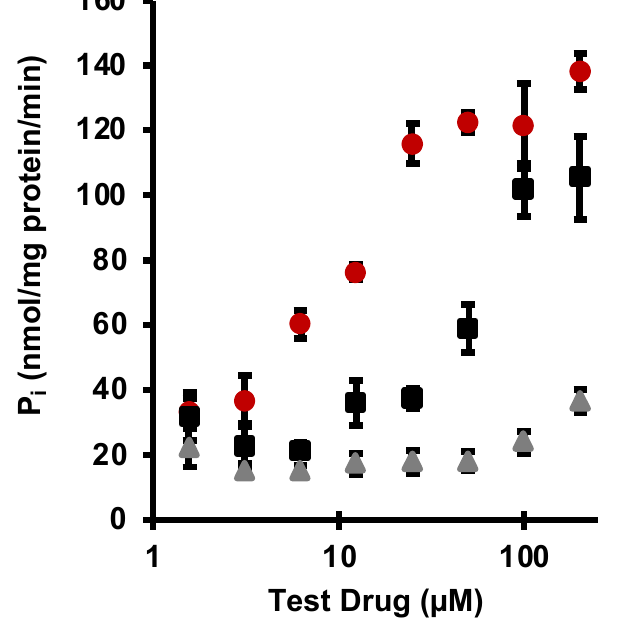
Figure 2. ATPase assay with IMQ, RSQ, and GDQ. In the activation test, IMQ, RSQ, and GDQ all stimulated vanadate-sensitive ATPase activity above baseline, confirming that the imidazoquinolines are substrates of P-gp. Error bars are standard deviation from the mean of experiments repeated in duplicate . Table 1. cLogP and K D values of imidazoquinolines. cLogP was calculated using ChemDraw 19.1